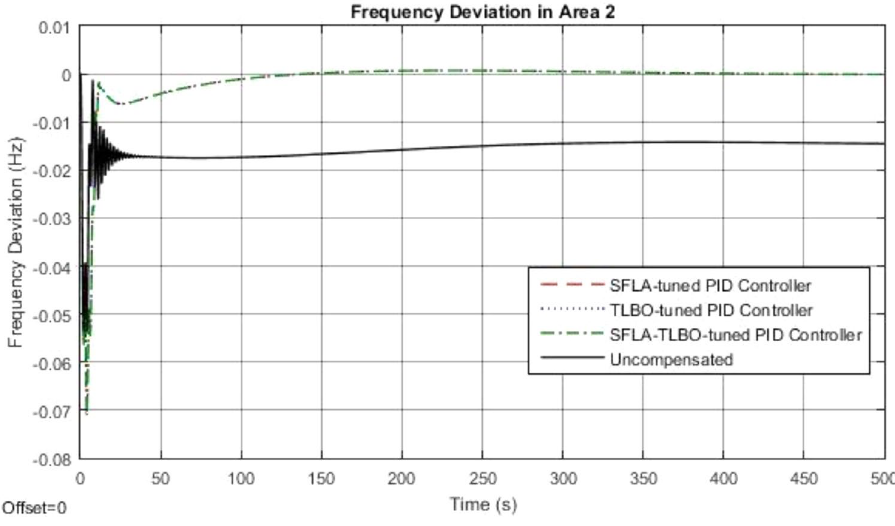
Fig. 13 Frequency deviation in area 2 for non-linear two-area system